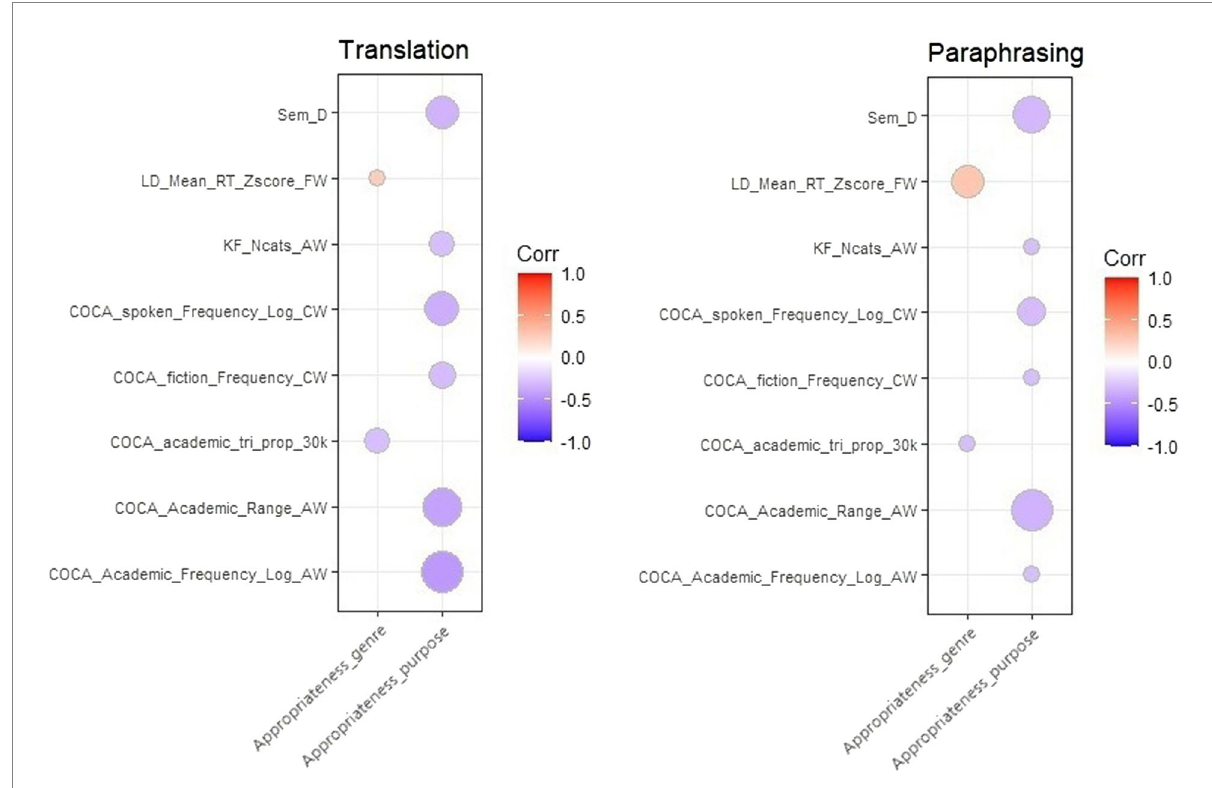
FIGURE 4 Index-Metric pairs with a significant correlation shared in translation and paraphrasing.